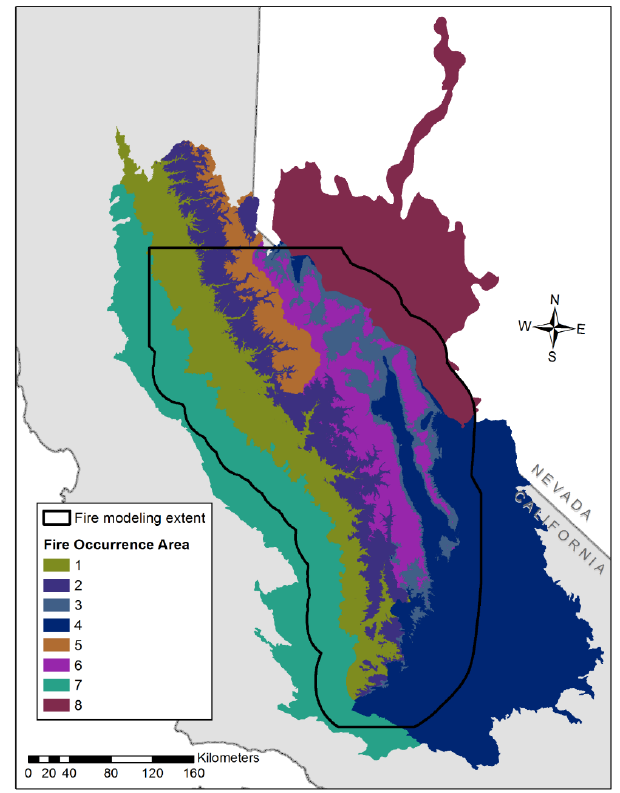
Figure 3. Eight fire occurrence areas (FOAs) used in the Southern Sierra Risk Assessment for summarizing historical fire occurrence. Table 1. Summary of total area, fire ‐ modeling area, and Remote Automated Weather Station (RAWS) station used in each of the eight fire occurrence areas (FOAs) used in the Southern Sierra Risk Assessment.